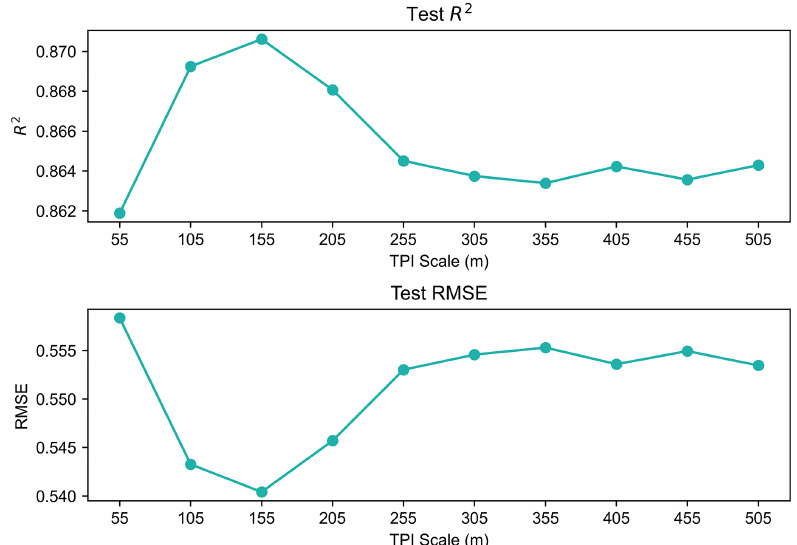
Figure A1. Random forest model performance for model runs using a range of TPI scales. The model performance is optimized when the TPI scale is